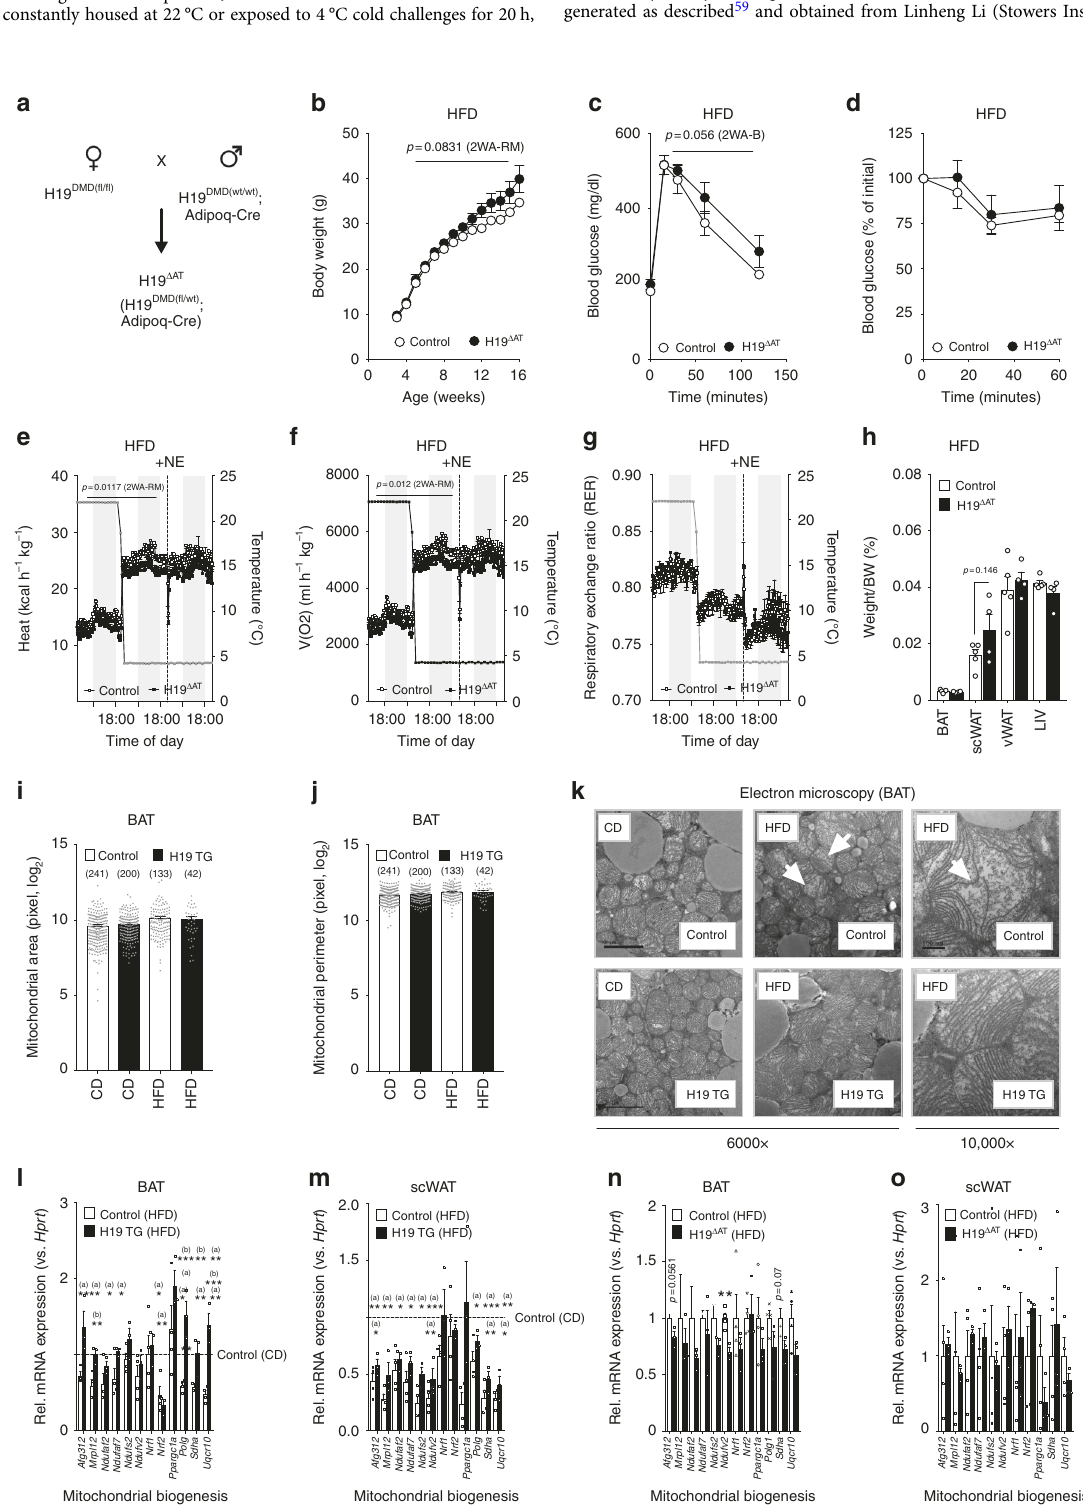
generated as described 59 and obtained from Linheng Li (Stowers